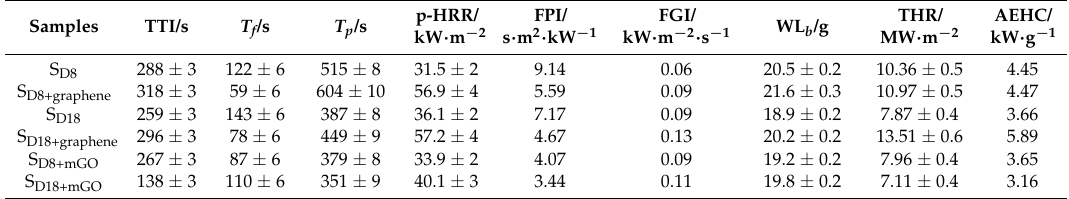
Figure 2. HRR of sample recorded by CC. Table 2. HRR parameters of samples tested by CC.